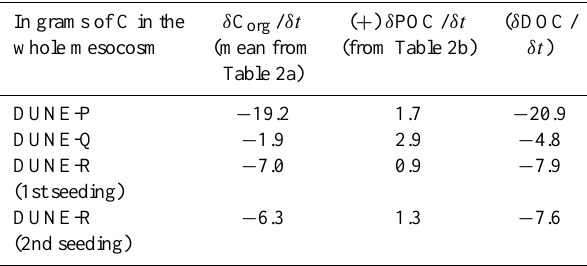
Table 2c. Estimated induced changes in the dissolved organic car- bon pool inside the DUST-MESO deduced from Tables 2a and 2b. In grams of C in